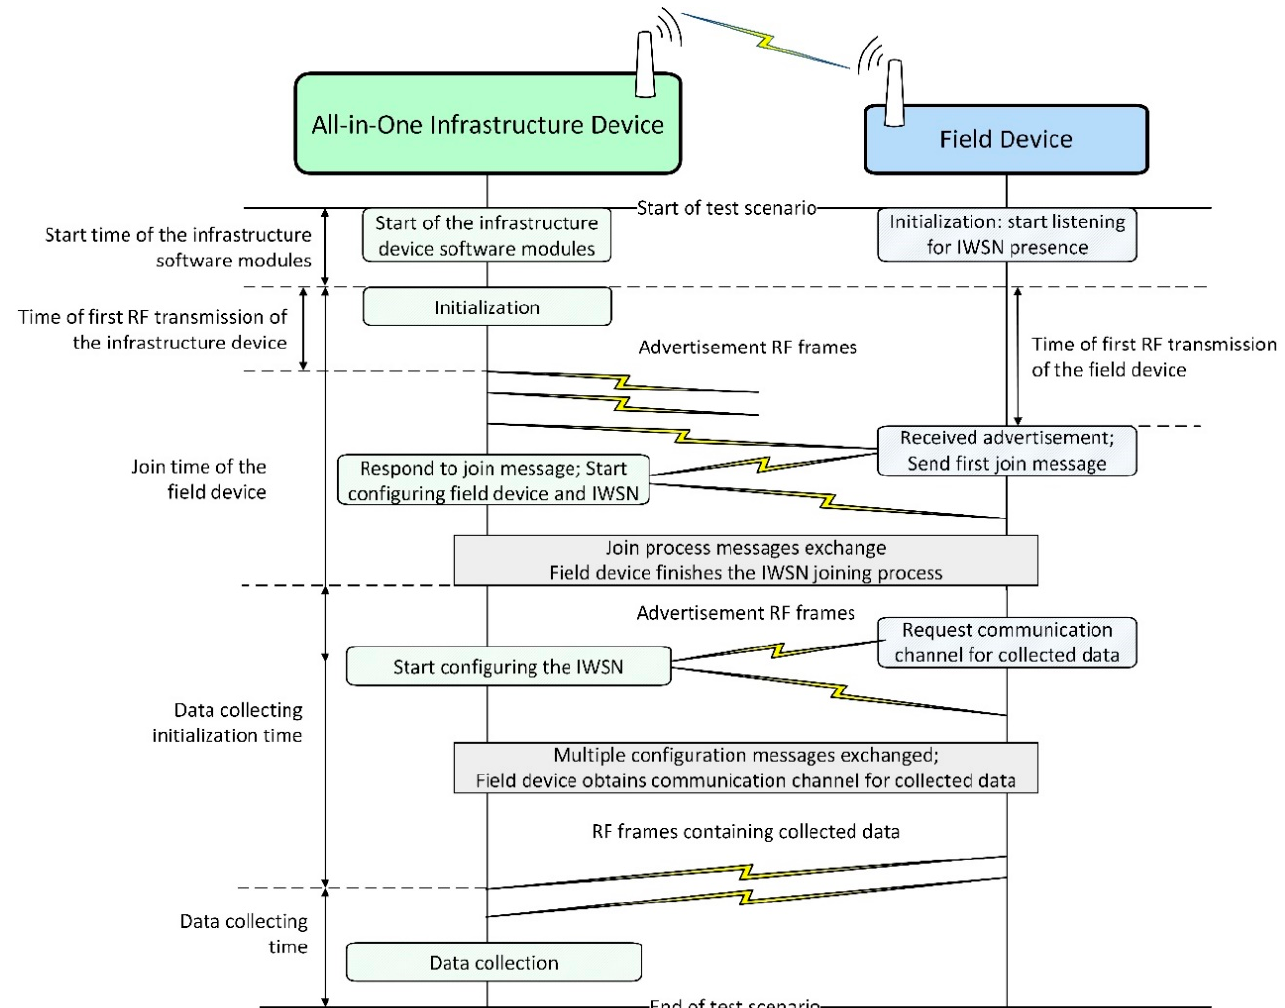
Figure 10. Summary of field device joining to application messages sequence in an ISA100.11a IWSN. The mean values of the evaluated metrics related to the timing information for all scenarios are presented in Figure 11.